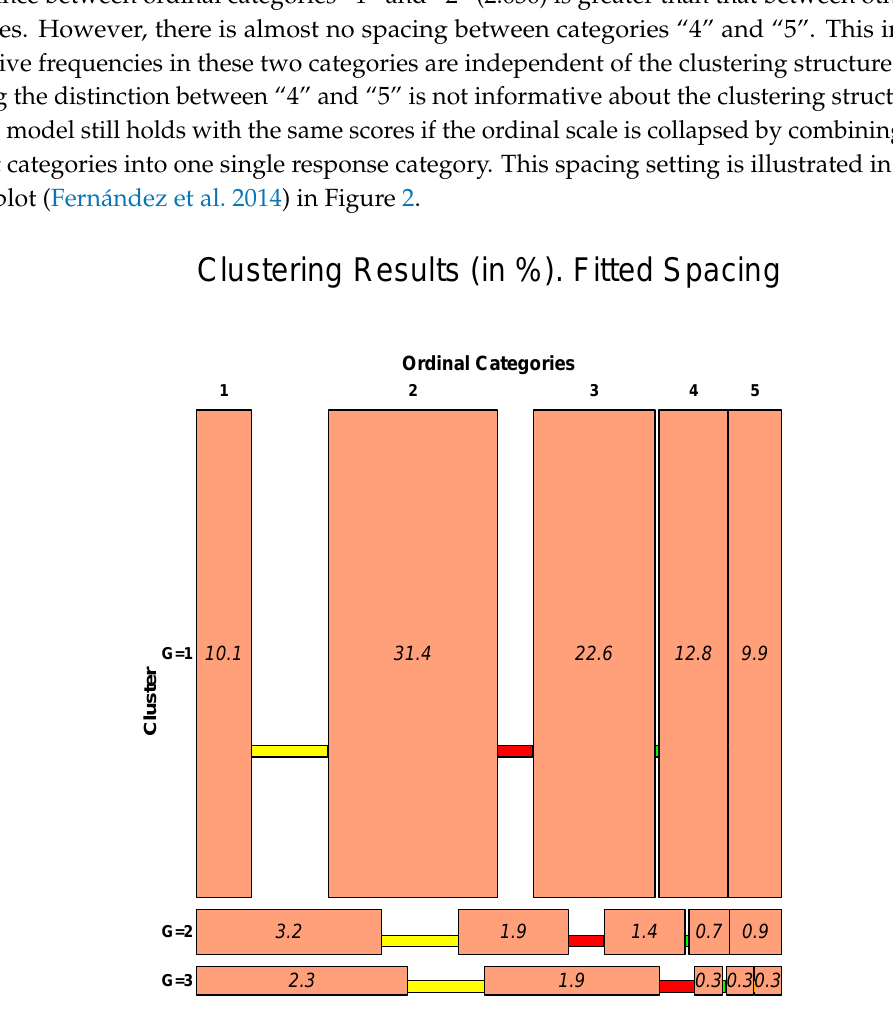
Figure 2. Spaced mosaic plot for the row clustering model G = 3. The height of each block is proportional to the number of claims in each claim cluster; the width is proportional to the numbers of each ordinal response within each cluster. The area represents the frequency of each combination, also shown numerically in each block. The relative spacing between ordinal categories (e.g., 2.636 between 0 and 1, shown by the yellow, red, and green bars) has been determined by the